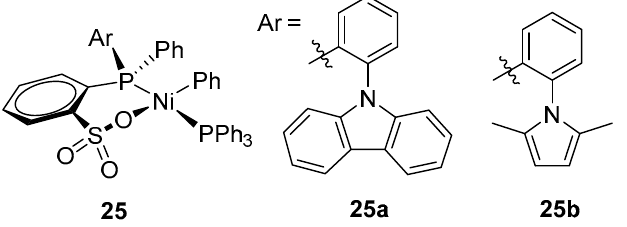
Figure 22. sp 2 Hybrid N-based aromatic carbazolyl and pyrrolyl units substituted phosphine-sul- fonate nickel catalysts 25a , b .